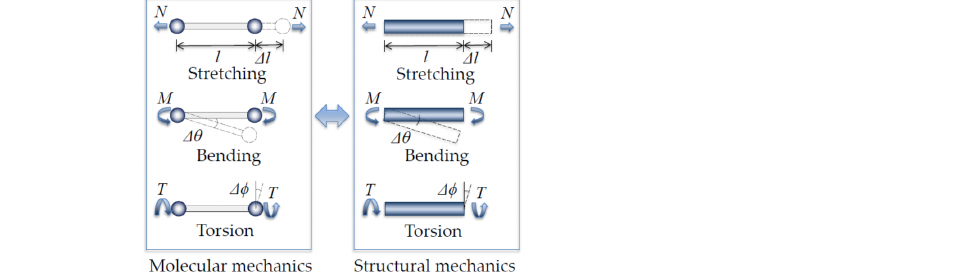
Figure 2. Continuum mechanical approach for modeling C–C chemical bond as an equivalent continuum beam from a linkage between molecular mechanics and structural mechanics.